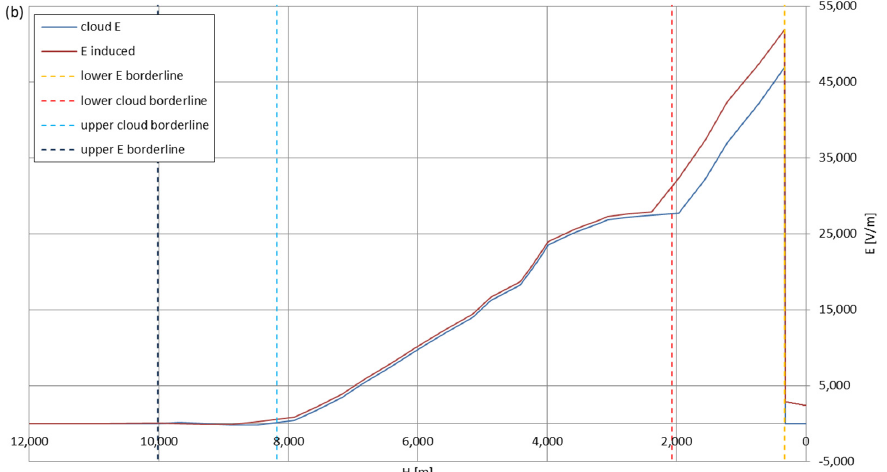
Figure 19. Maximum electric field strengths around the wire antenna re-entering through Nimbo- stratus cloud of mixed charge structure, Tashkent data: ( a ) ‘static’ case and ( b ) ‘dynamic’ case.